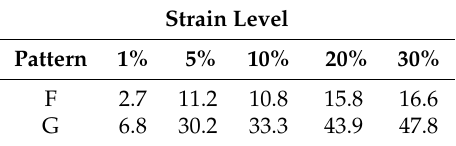
Figure 8. Transverse Poisson’s ratio as a function of strain under all patterns. Table 1. Percentage decrease in Pattern A’s transverse Poisson’s ratio compared to Patterns F and